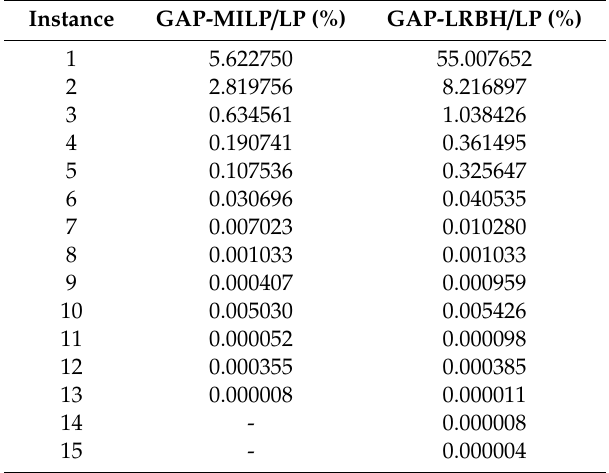
Table 8. Comparison between the techniques with the LP solution.